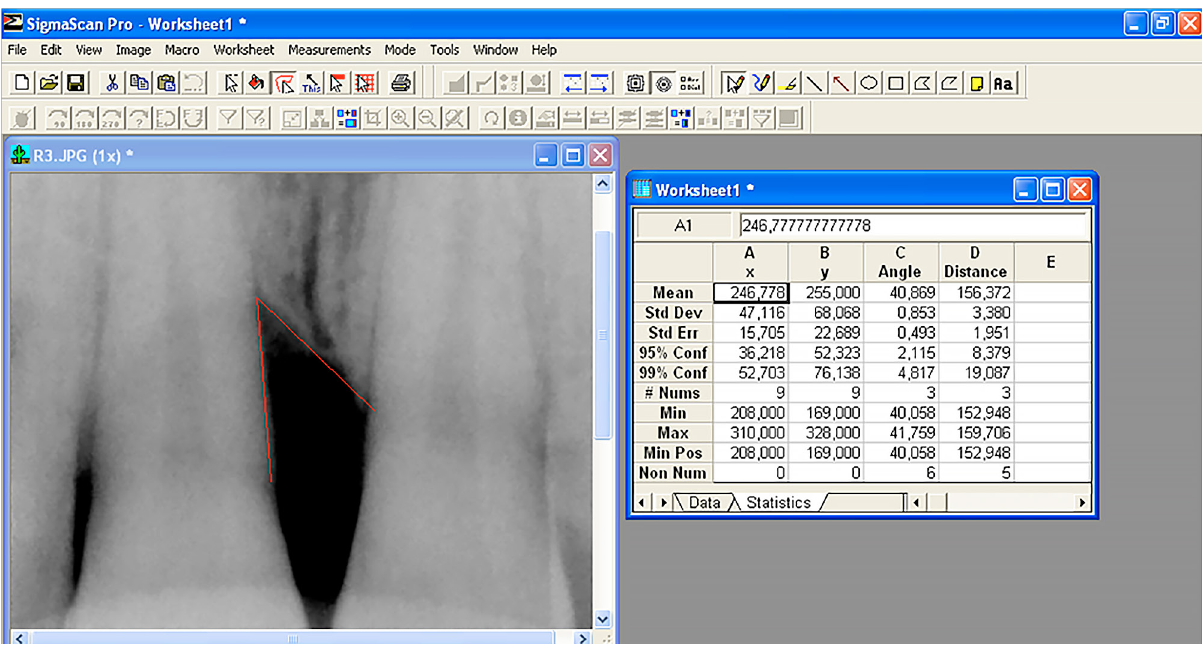
Figure 1. Measurements of vertical bone loss and radiographical defect angle with digital radiography imaging